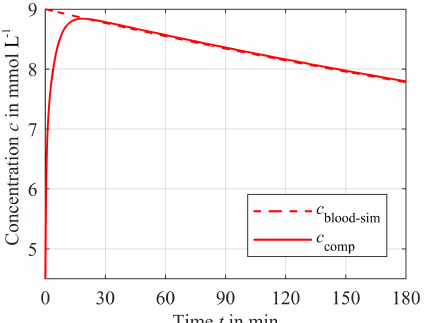
Figure 5. Simulation of the required time t 99 for 99% of concen- tration equalization between blood and sensor compartment versus the distance h s for diffusion coefficients D K = 1.9 × 10 − 9 m 2 s − 1 (red dashed line), D Na = 1.4 × 10 − 9 m 2 s − 1 (blue solid line) and D Ca = 0.9 × 10 − 9 m 2 s − 1 (black dotted line).